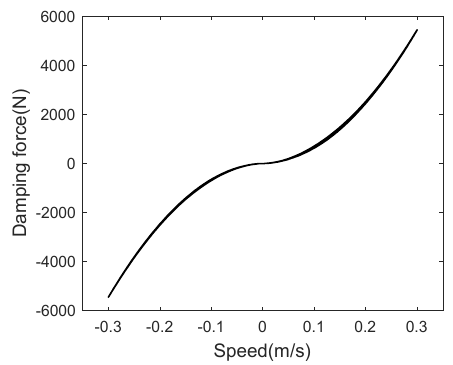
Figure 2. The curve of damping and inertia force of a dual-cylinder fluid inerter. As can be seen from Figures 3 and 4, the mechanical properties of a dual-cylinder fluid inerter are equivalent to nonlinear damping and linear inerter in parallel.